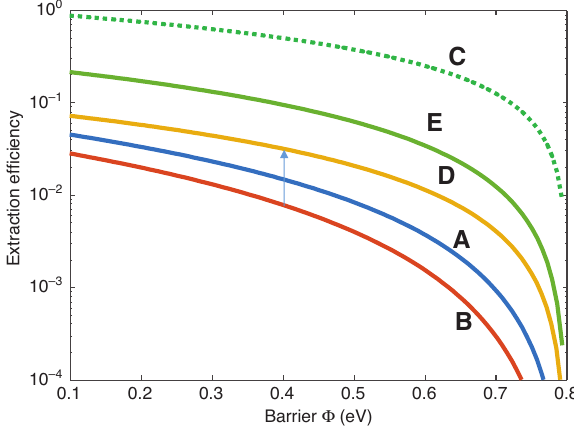
Figure 12: Impact of interface rougness on carrier injection. (A) Carrier injection from the metal into silicon across a smooth interface. Only electrons with an incidence angle less than θ (B) Six valleys in the conduction band of Si. Electrons get injected only into the two valleys along [100] direction. (C) Carrier injection from the metal into silicon across a rough interface with momentum conservation restriction entirely lifted.